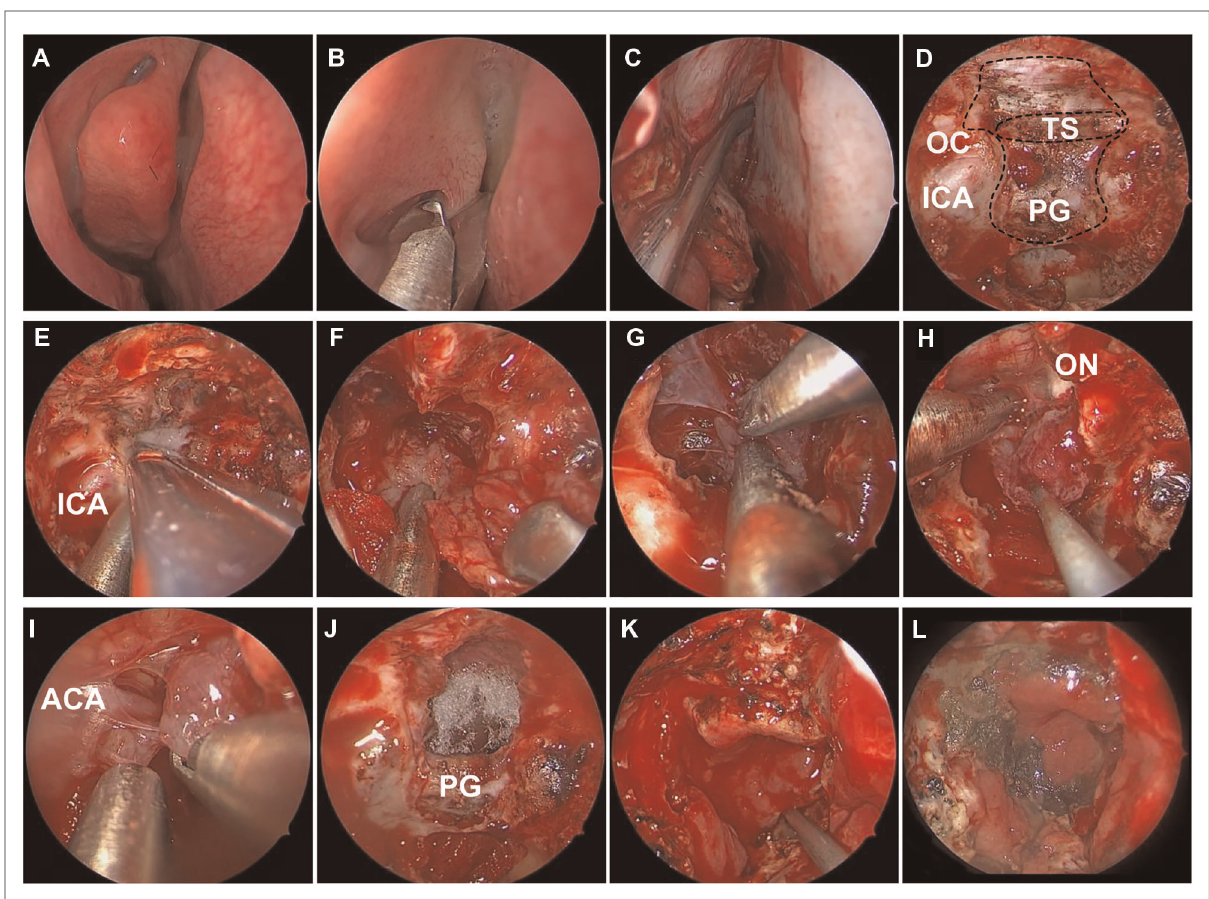
FIGURE 2 Intraoperative photos of endoscopic endonasal surgery for tuberculum sellae meningioma. ( A ) Nasal mucosa constriction. ( B ) Remove the middle turbinate. ( C ) Vascularized nasoseptal fl ap separation. ( D ) Expose the anterior fossa dura. ( E ) Enlarge the skull base exposure. ( F ) Intratumor decompression. ( G ) Dissociate the tumor boundary. ( H ) Resect the main part of tumor. ( I ) Dissect the adherent tumor from the anterior cerebral artery complex. ( J ) Gross total resection of tumor. ( K ) Reconstruct the skull base by vascularized nasoseptal fl ap. ( L ) Probe the nasal 10 days after surgery. ICA, internal carotid artery; PG, pituitary gland; TS, tuberculum sellae; OC, optic canal; ON, optic nerve; ACA, anterior cerebral